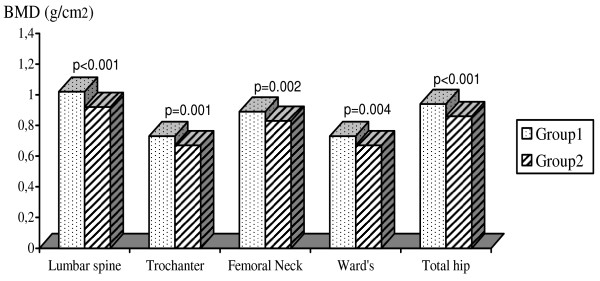
Means for BMD of various skeletal sites according to the timed get-up-and-go test (TGUGT). Abbreviations: BMD, bone mineral density. Group 1 was below the best cut-off (≤ 14.25 sec) and group 2 was above the best cut-off (>14.25 sec).